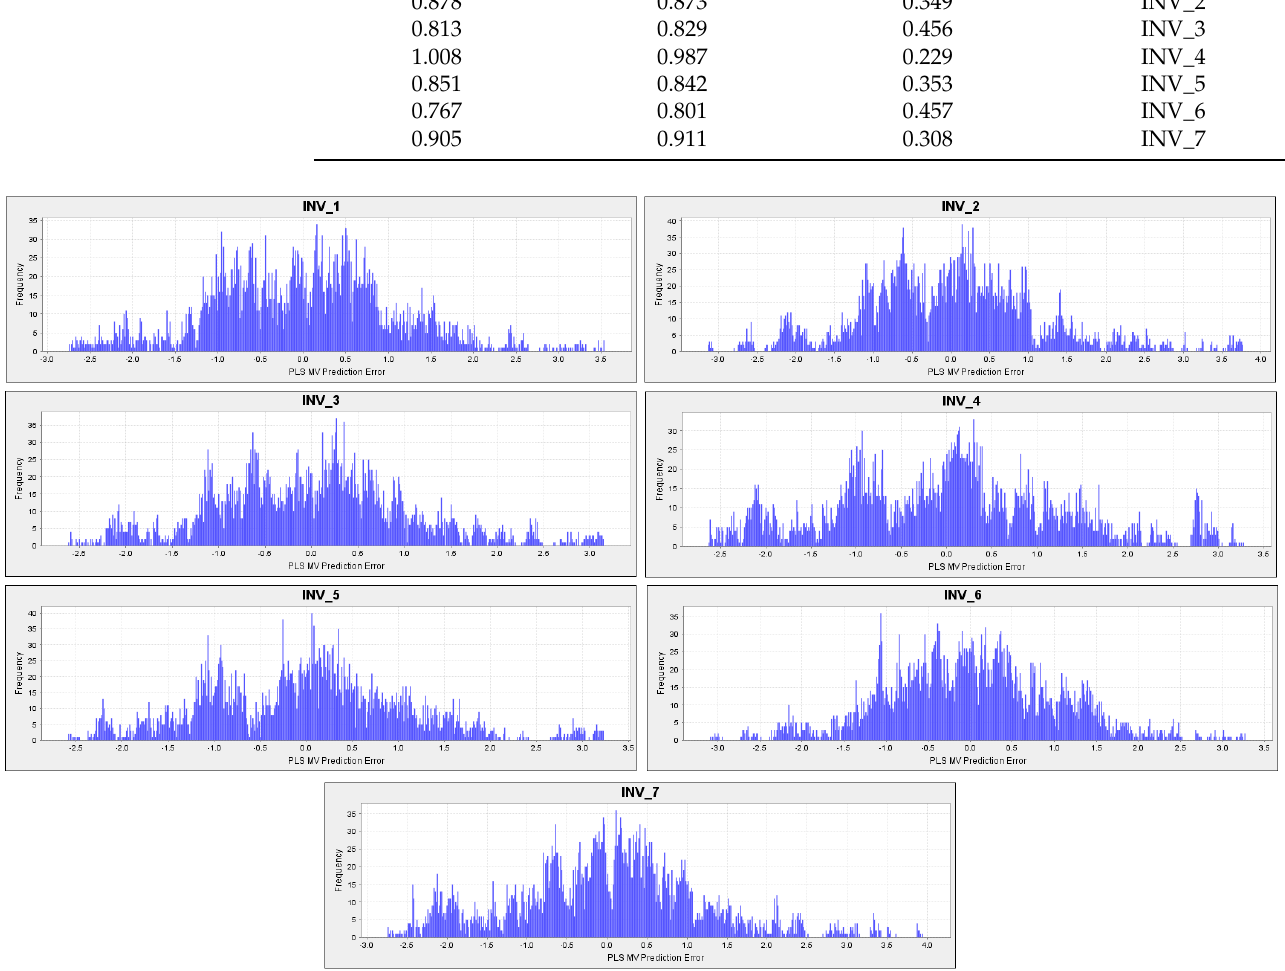
Figure 2. PLS-MV prediction errors for indicators of INV. Source: Authors’.